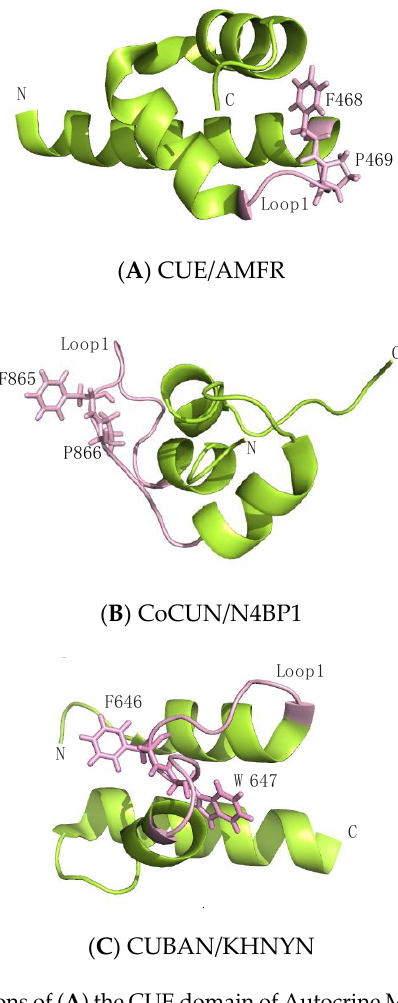
Figure 3. Cartoon representations of ( A ) the CUE domain of Autocrine Motility Factor Receptor (AMFR, PDB 4G3O), ( B ) the CoCUN domain of N4BP1 and ( C ) the CUBAN domain of KHNYN (PDB 2N5M). The FP/FW motifs are shown in sticks and the residues located in the loop1 are colored in light pink.